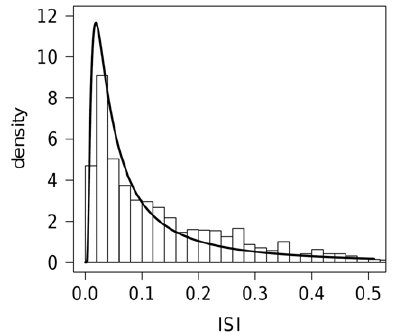
Figure 9. Histogram of interspike intervals from a typical record of the data. The thick curve shows the shape of probability density function fitted by the maximum likelihood method. Estimated dispersion coefficients are c v ¼